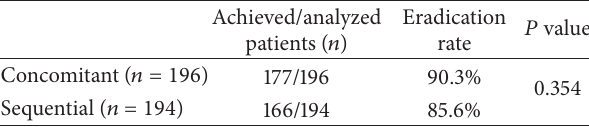
Table 2: First-line eradication rates of Helicobacter pylori